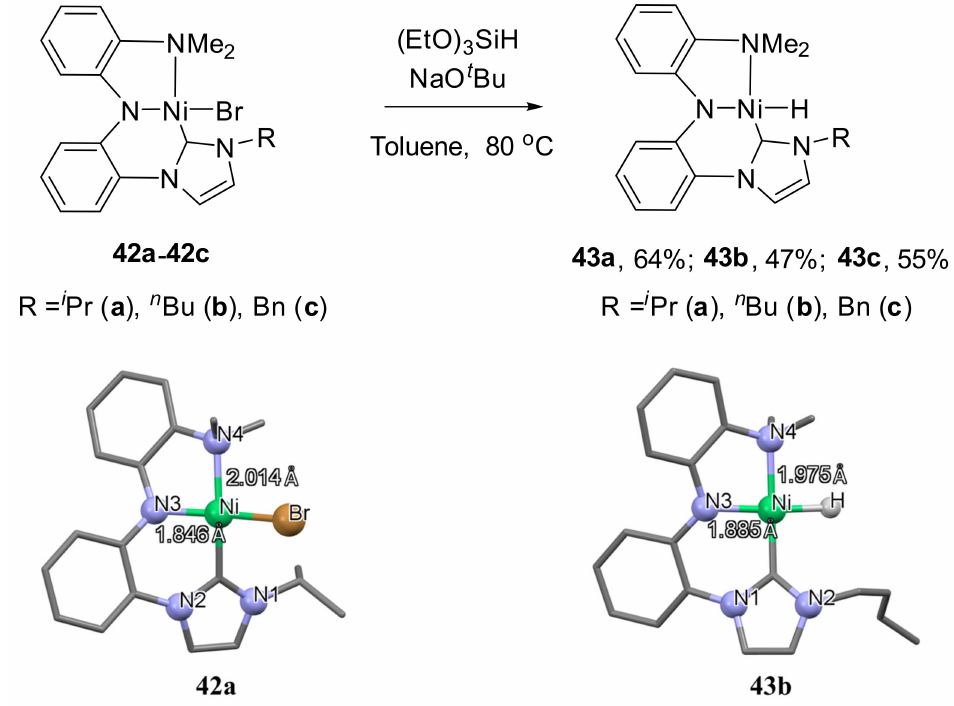
Obtained complexes showed high catalytic activity in Kumada cross-coupling reac- tions of aryl chlorides or dichlorides with aryl Grignard reagents under mild conditions as well as in Sonogashira coupling reactions of aliphatic halides with terminal alkynes [136]. It has also been confirmed that the hydrogenation of nickel halides 42a – 42c in the presence of (EtO) 3 SiH and NaO t Bu as a base leads to the formation of hydrido nickel complexes 43a – 43c (Scheme 22) [137]. According to the X-ray diffraction analysis of 42a and 43b , the Ni − N(amine) bond distance is remarkably longer than the Ni − N(amide) due to the strong trans influence of the carbon atom of the NHC coordination moiety. Complex 43a exhibited high catalytic activity in the hydrodehalogenation of organic halides.